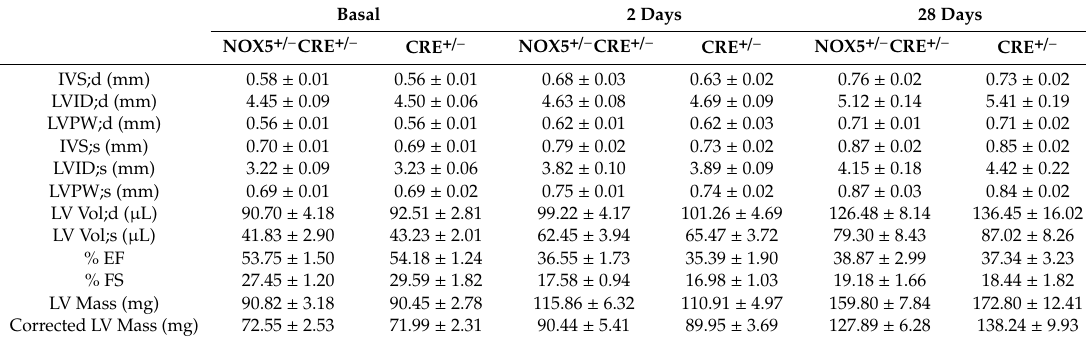
Table 3. Echocardiographic parameters studied in left anterior descending coronary artery (LAD) coronary ligation mice at baseline and post-MI. Basal 2 Days 28